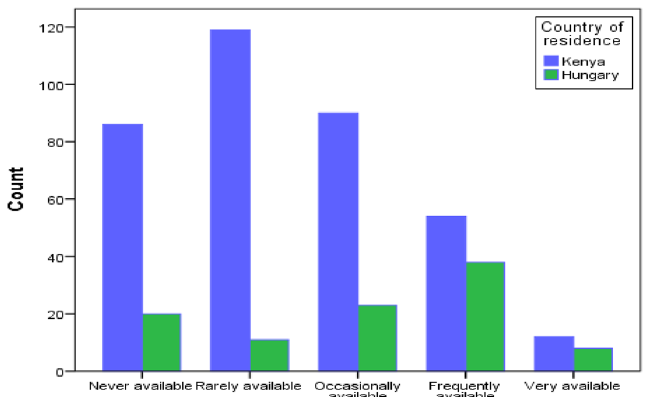
Figure 1. The figure represents a comparative display of the rate at which vaccines are perceived as available between the two sampled populations in Kenya and Hungary (1–5 Likert scale, the x-axis represents responses from respondents, the y-axis represents the count in frequency).